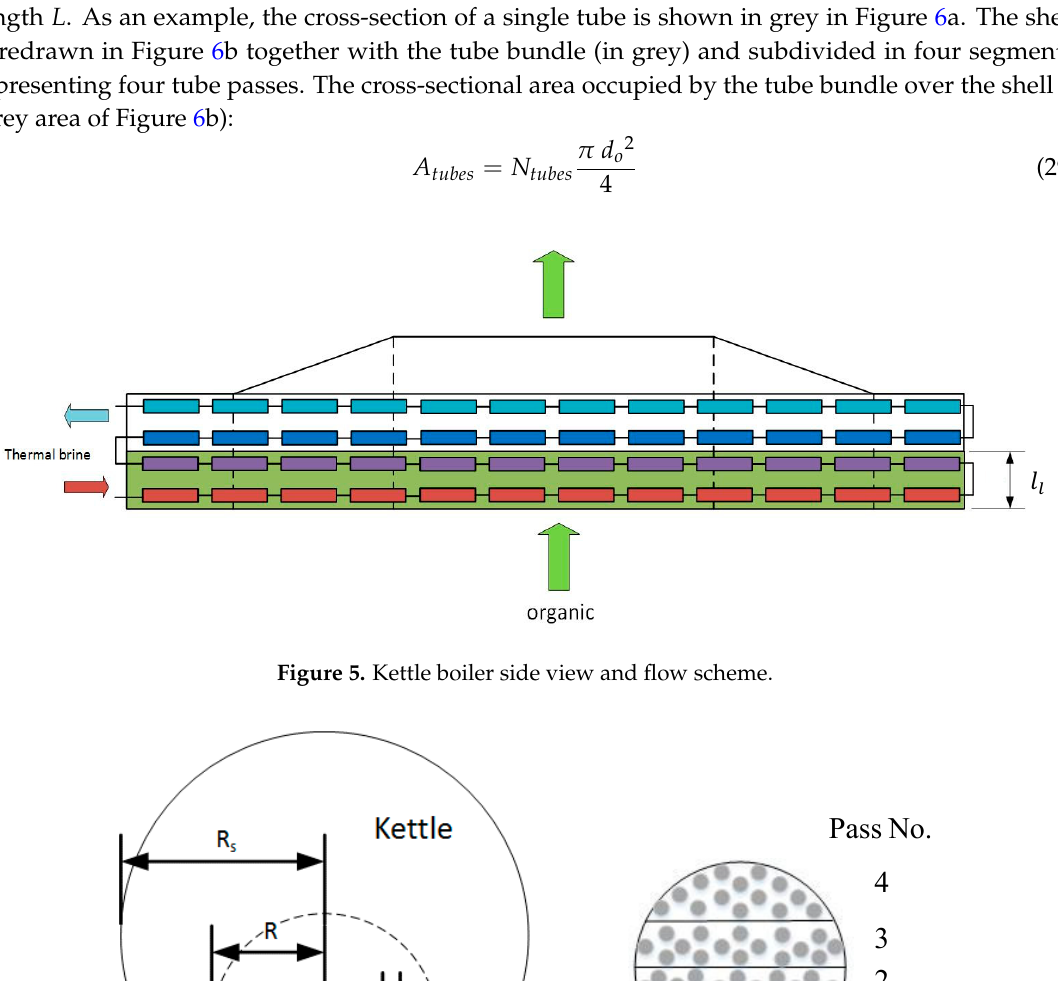
Figure 6. Kettle boiler cross section: ( a ) shell and ( b ) tube sheet.